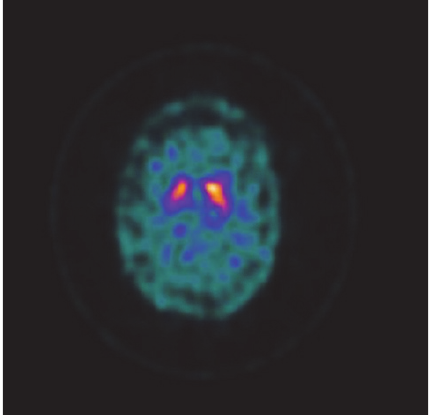
Figure 1: DaTscan shows asymmetric radiotracer uptake with mildly decreased uptake in the right